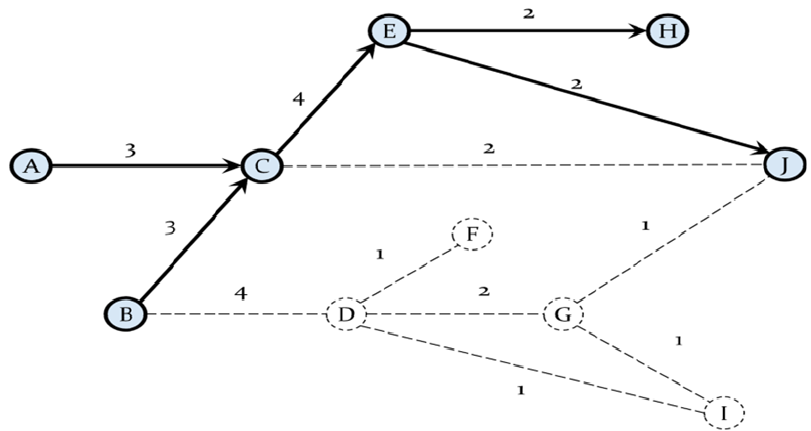
Figure 2. Search path count ( SPC) of a simple citation network.